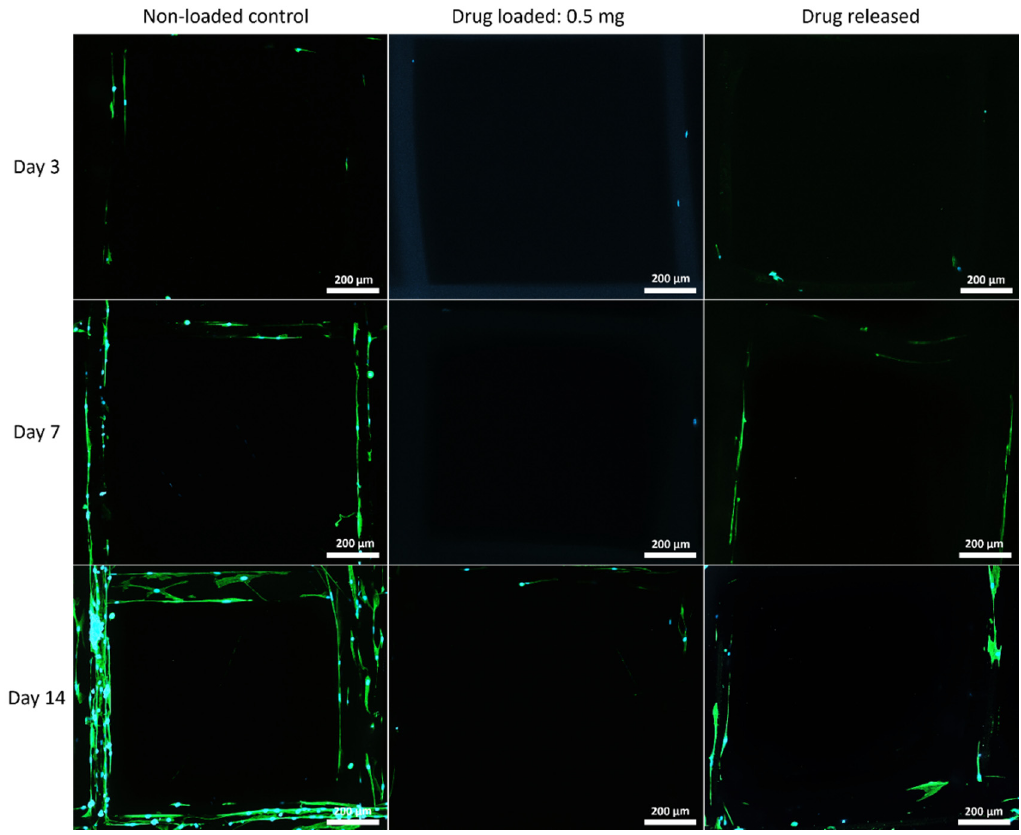
Figure 7. MSC cell morphology on PCL mesh groups at all time points. Cell nuclei are shown in blue and cytoskeleton shown in green.